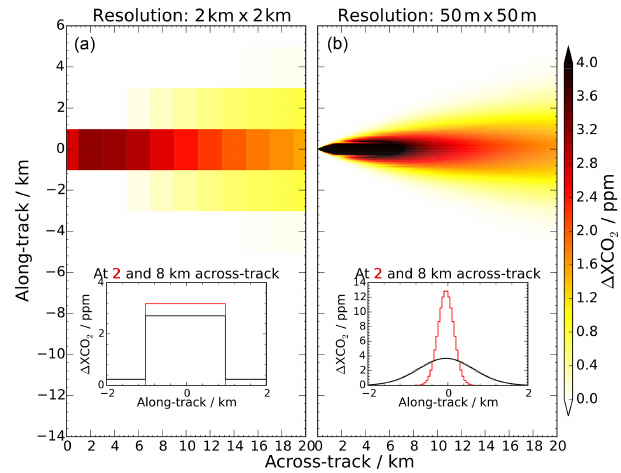
Figure 1. Schematic Gaussian plume of the XCO 2 enhancement ( (cid:49) XCO 2 ) originating from a power plant with a 12.3Mt CO 2 yr − 1 emission rate (wind from left to right, Gifford–Pasquill stabil- ity class C; power plant at the origin; satellite assumed to move from bottom to top, sampling left to right) as seen (without noise) by hypothetical satellite spectrometers with 2km × 2km ground pixels (a) and with 50m × 50m ground pixels (b) . Insets show (cid:49) XCO 2 measured by the sensors at 2km (red) and 8km (black) downwind of the source along the plume cross section (note differ- ent (cid:49) XCO 2 scales in